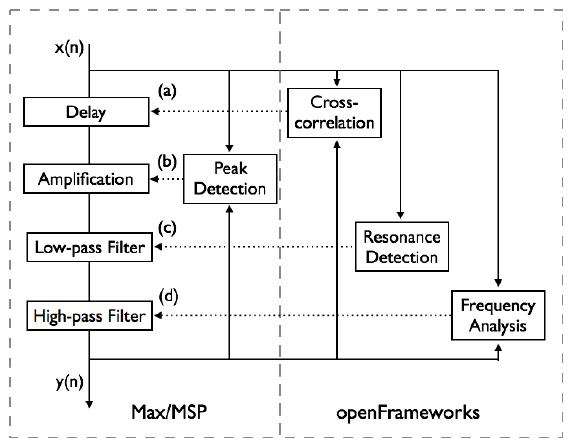
Figure 13. Overview of the system implemented as software (Max/MSP and openFrameworks), for ( a ) tempo control depending on room reverberation (Section 4.1), ( b ) volume control depending on ambient noise volume (Section 4.2) and ( c ) timbre control depending on frequency response of the acoustic environment (Section 4.3) and ( d ) timbre control depending on distribution of room modes (Section